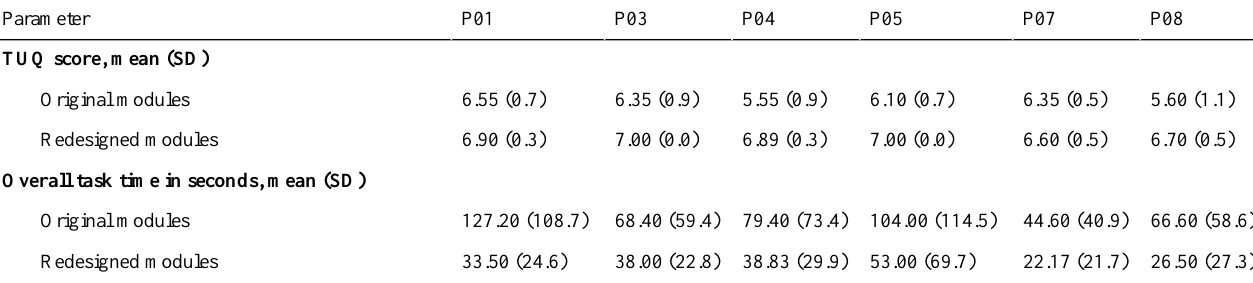
Table 5. Telehealth Usability Questionnaire (TUQ) scores and overall task time for each participant. P08P07P05P04P03P01Parameter TUQ score, mean